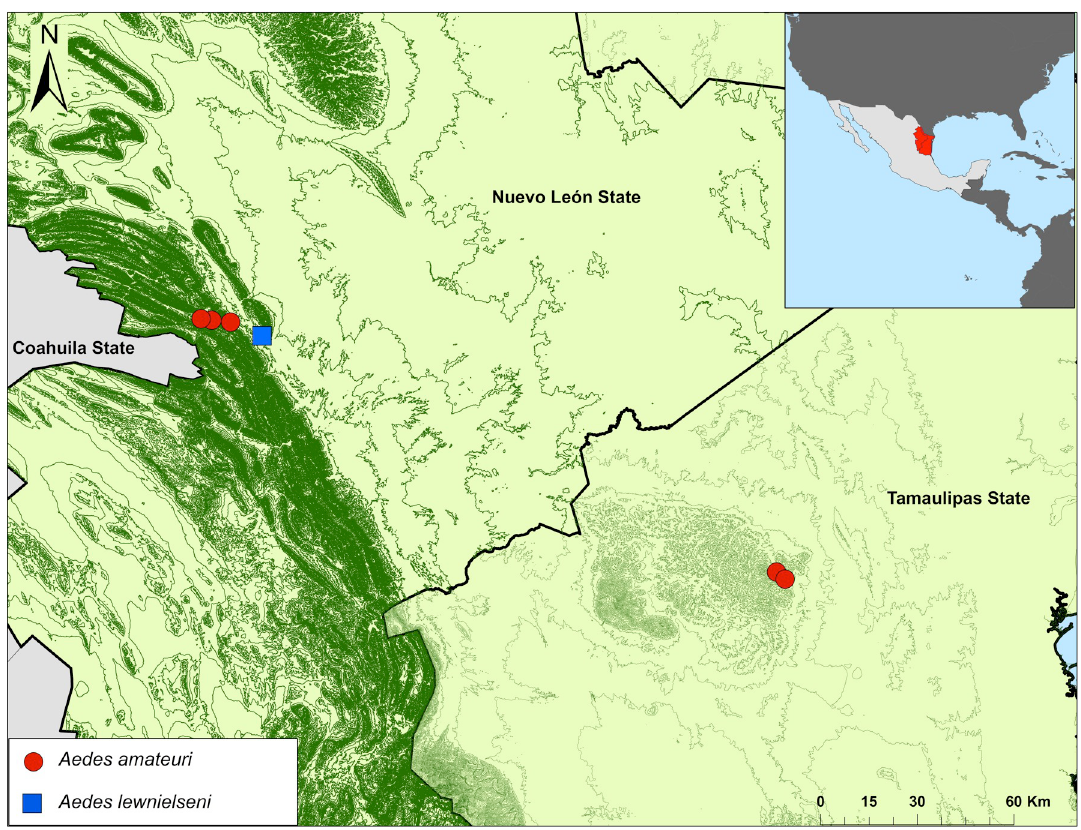
Fig 5. Distribution of Ae . amateuri n. sp. and Ae . lewnielseni n.